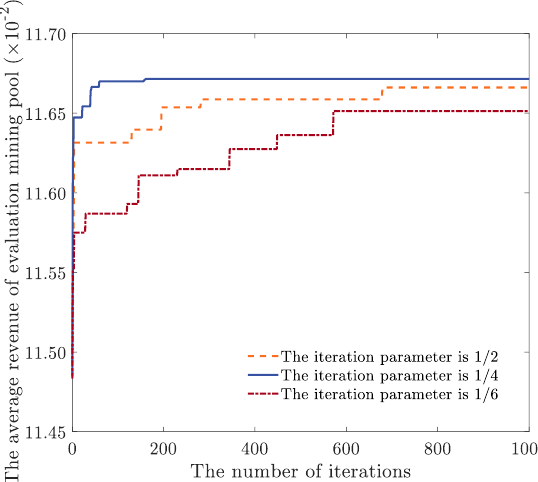
Figure 3. Optimization stage switching parameter diagram.